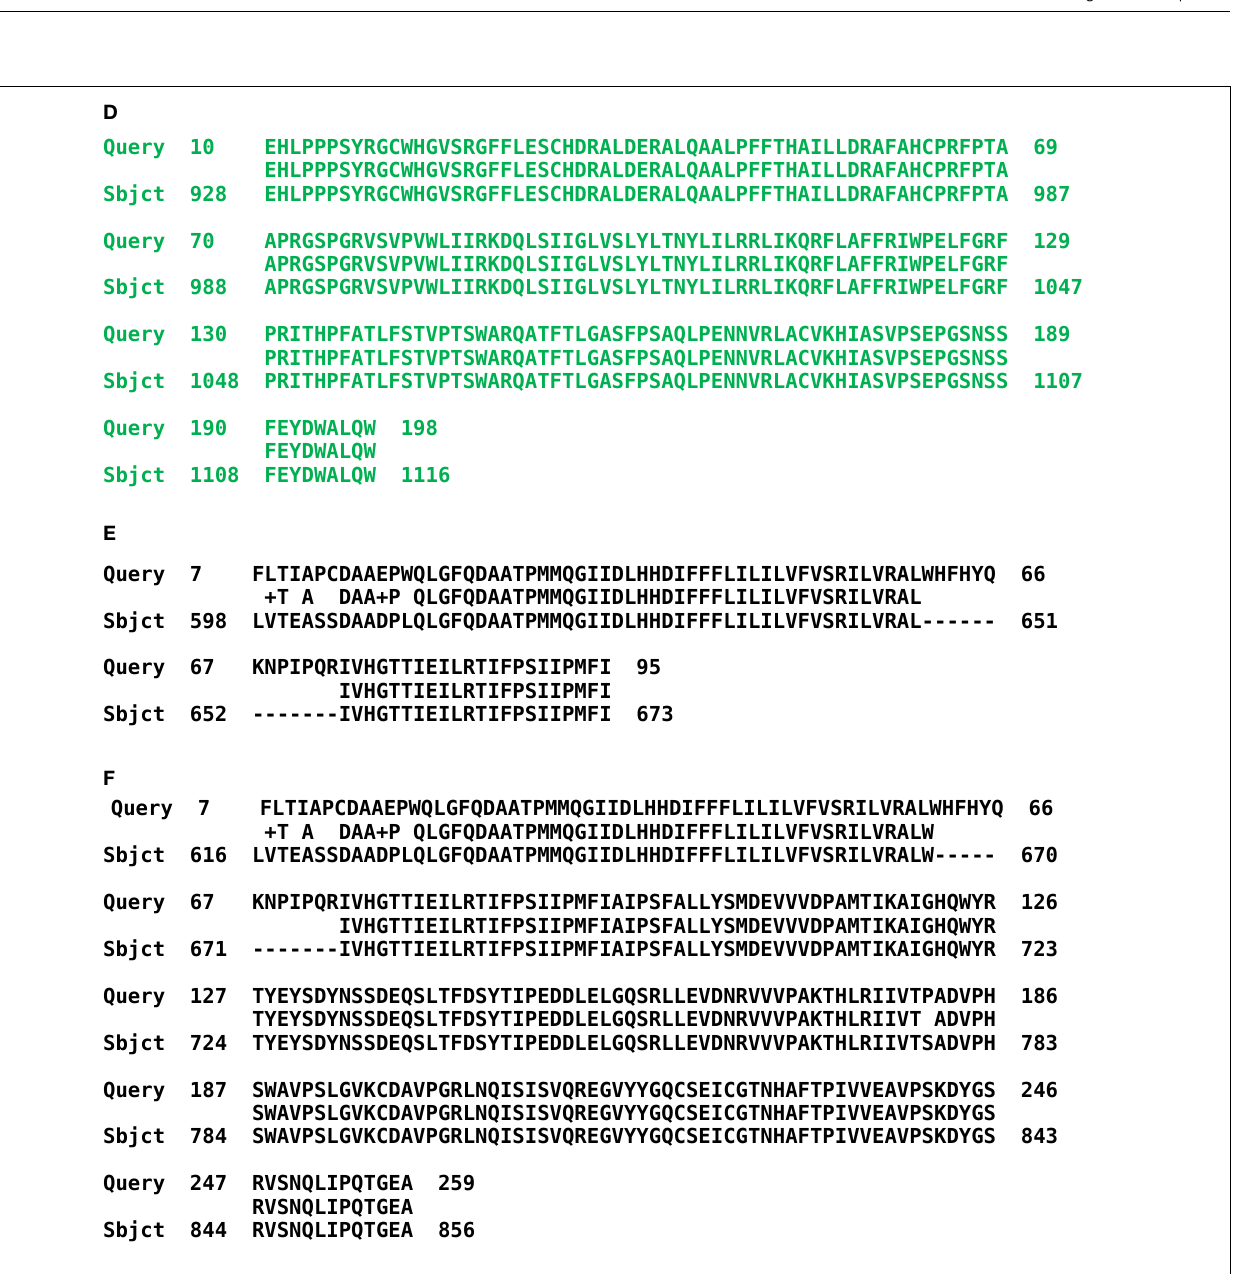
Underlined is a perfect (99%) homology between Vicia faba mitochondrion gene of ATP synthase F1 subunit 1 and ORF1116. (C) A blue colored homology between mitochondrial ORF134 and ORF1116. (D) A green colored homology between mitochondrial ORF198 and ORF1116. (E) Homology between Vicia faba mitochondrion cox2 gene (259aa) and ORF1116. (F) Homology between Vicia faba mitochondrion cox2 gene (259aa) and